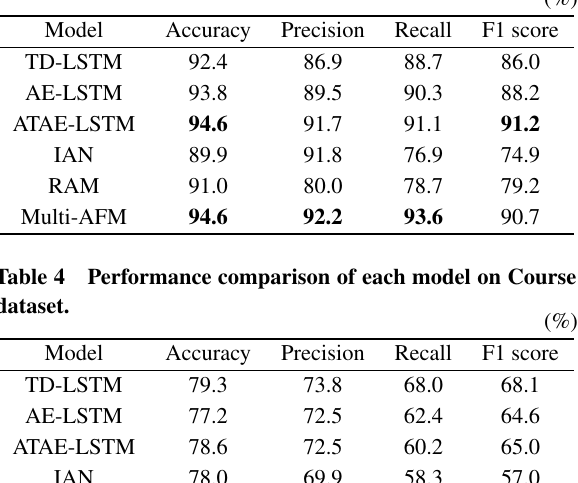
Table 3 Performance comparison of each model on Education dataset.